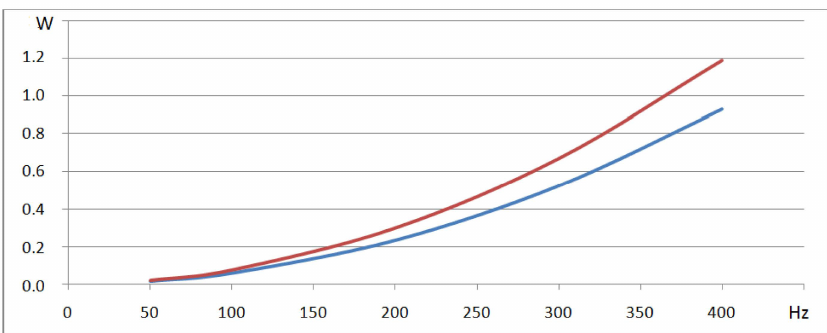
Figure 30. In blue, the eddy current losses in the cube (Figure 29a) using analytical formulation. In red, the eddy current losses in the cylinder (Figure 29b) with the use of FEM calculation (2D